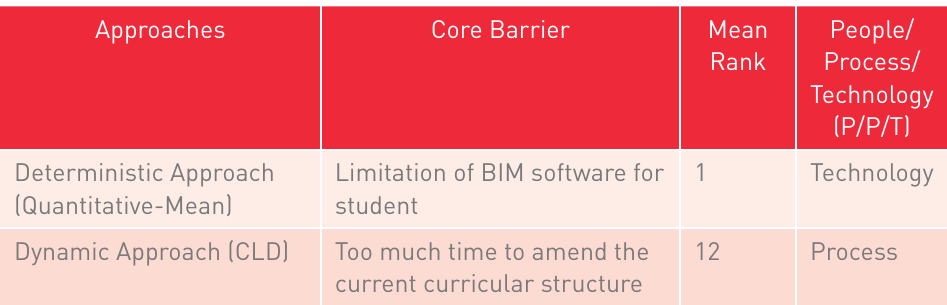
Comparison between the top barriers identified using Deterministic and Dynamic